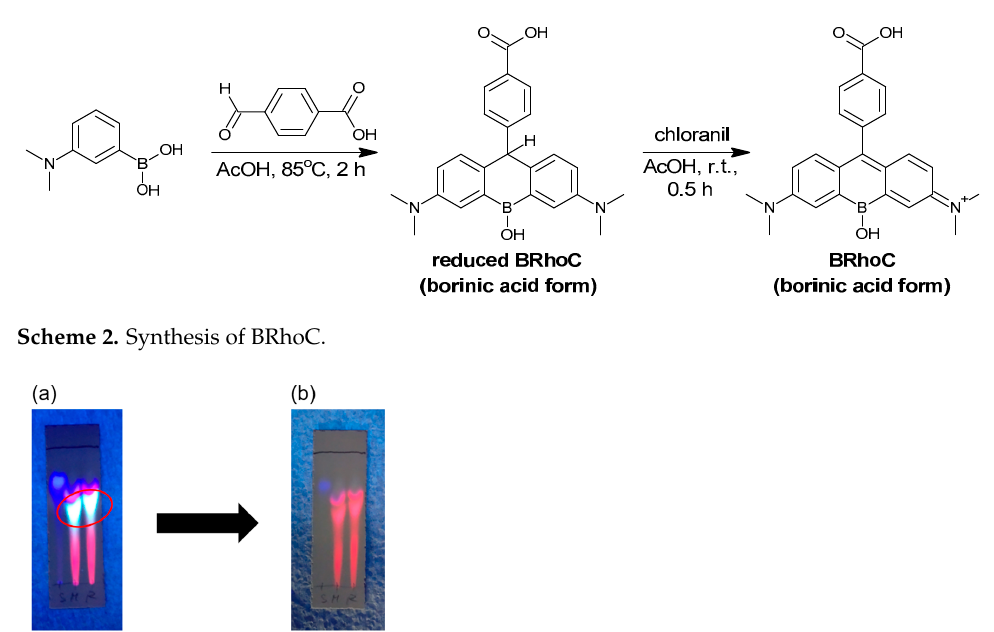
MS (FAB, positive mode, matrix: glycerol, solvent: CH 3 OH), Figure S4: 473. The expected